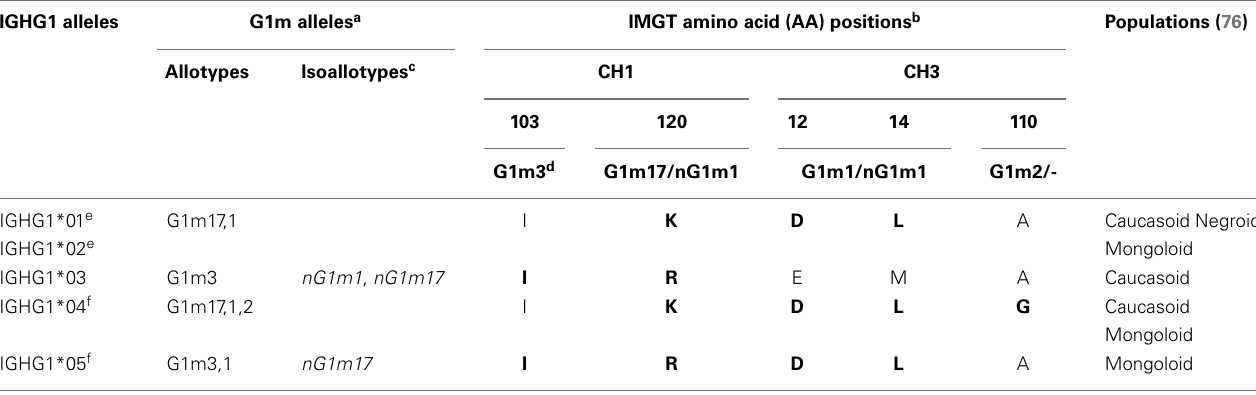
Table 9 | Correspondence between the IGHG1 alleles and G1m alleles . IGHG1